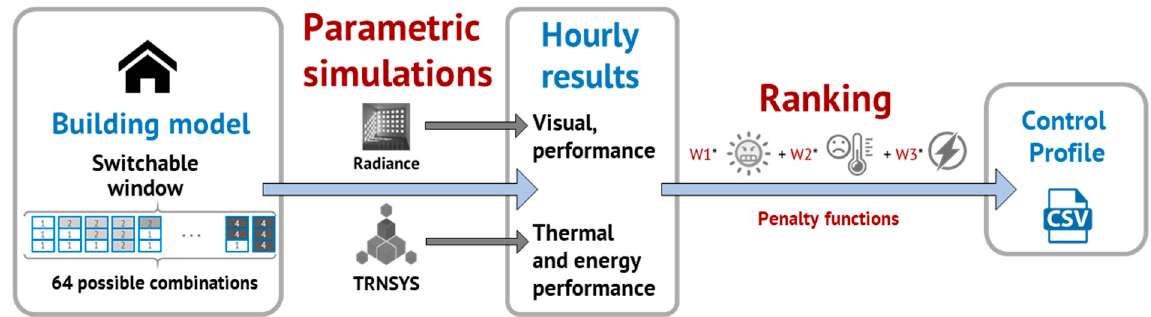
Figure 5. The simulation-based framework was used to derive the penalty-based profile (CtrlPen) (adapted from [23]).